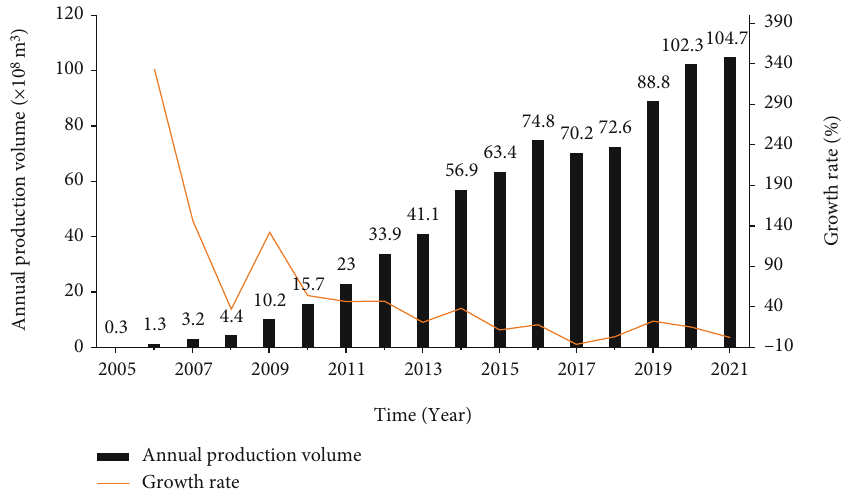
Figure 1: Annual production volume and growth rate of CBM wells in China